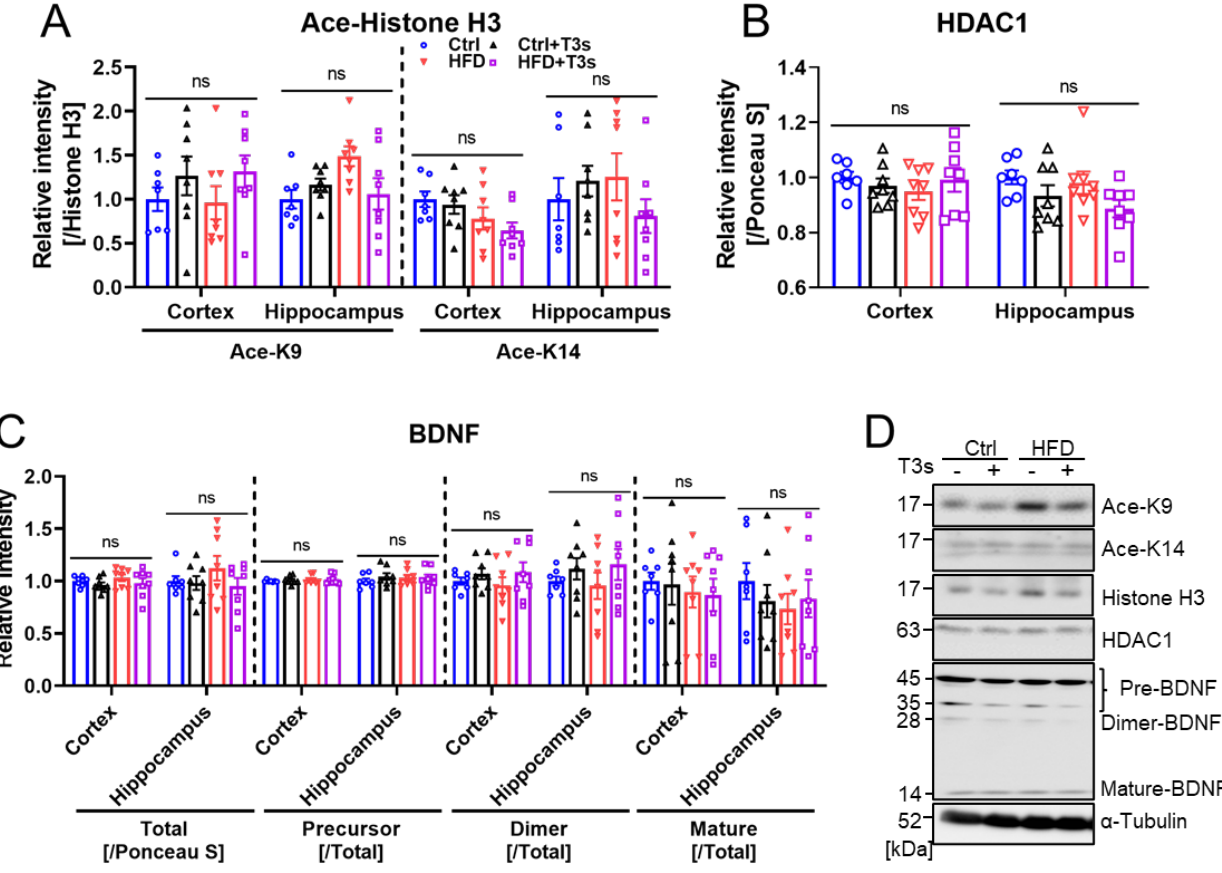
Figure 5. Histone H3 acetylation and BDNF in the brain. ( A – C ) Quantitative results of acetylated (Ace)-histone H3 (K9), (K14), HDAC1, total-BDNF, precursor-BDNF (Pre-), dimer-BDNF (Dimer-), and mature-BDNF. ( D ) Representative western blotting images. (Ctrl, n = 7; Ctrl + T3s, HFD and HFD + T3s, n = 8).